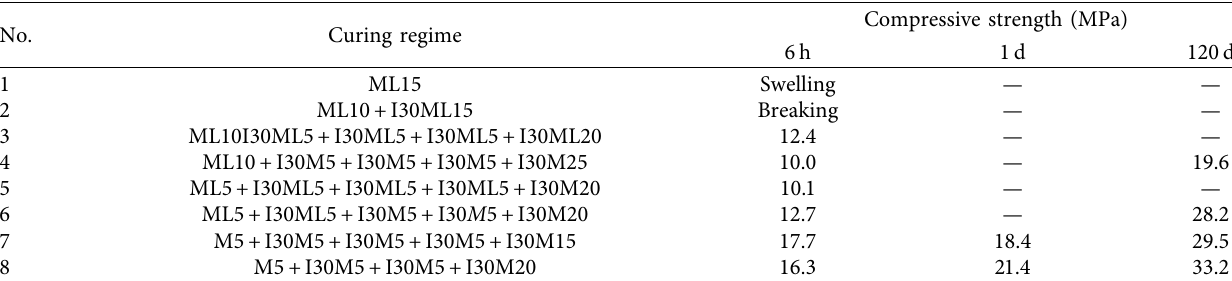
Table 3: The curing regime and compressive strength.